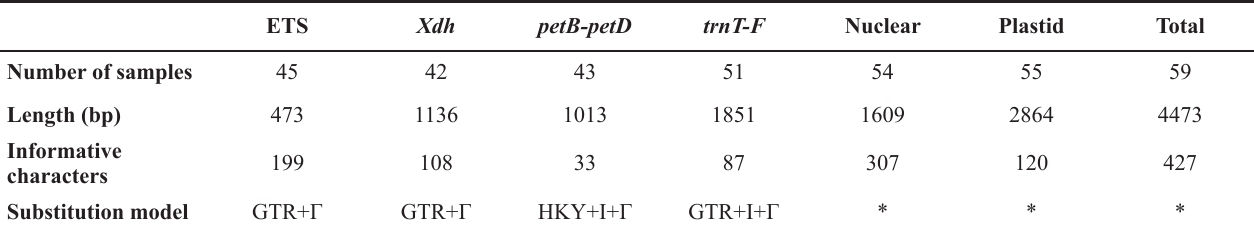
Table 2 – Information on the DNA regions used in this study. *Each region had its own partition with substitution model as specified for the separate